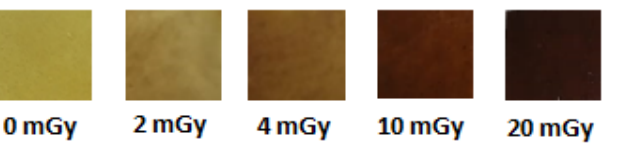
Figure 2. Direct perceived color change of PVA/Ag + /NBT films irradiated with different X-ray doses.